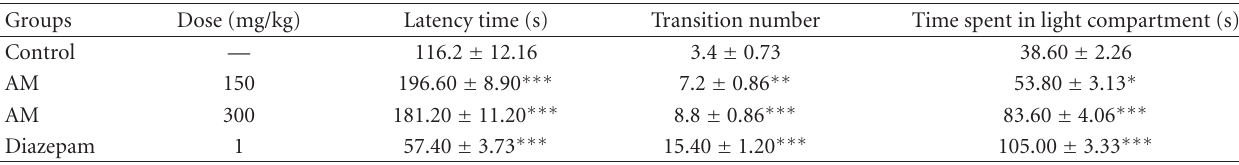
Table 2: E ff ects of repeated administration of the aqueous extract of A. multiflora (i.p.) on the light-dark transition test with mice.